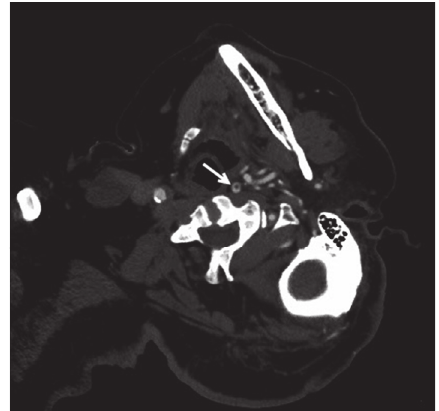
Figure 2: Axial image from CT angiogram demonstrates free floating thrombus within the internal carotid artery lumen “donut sign” (white arrow).